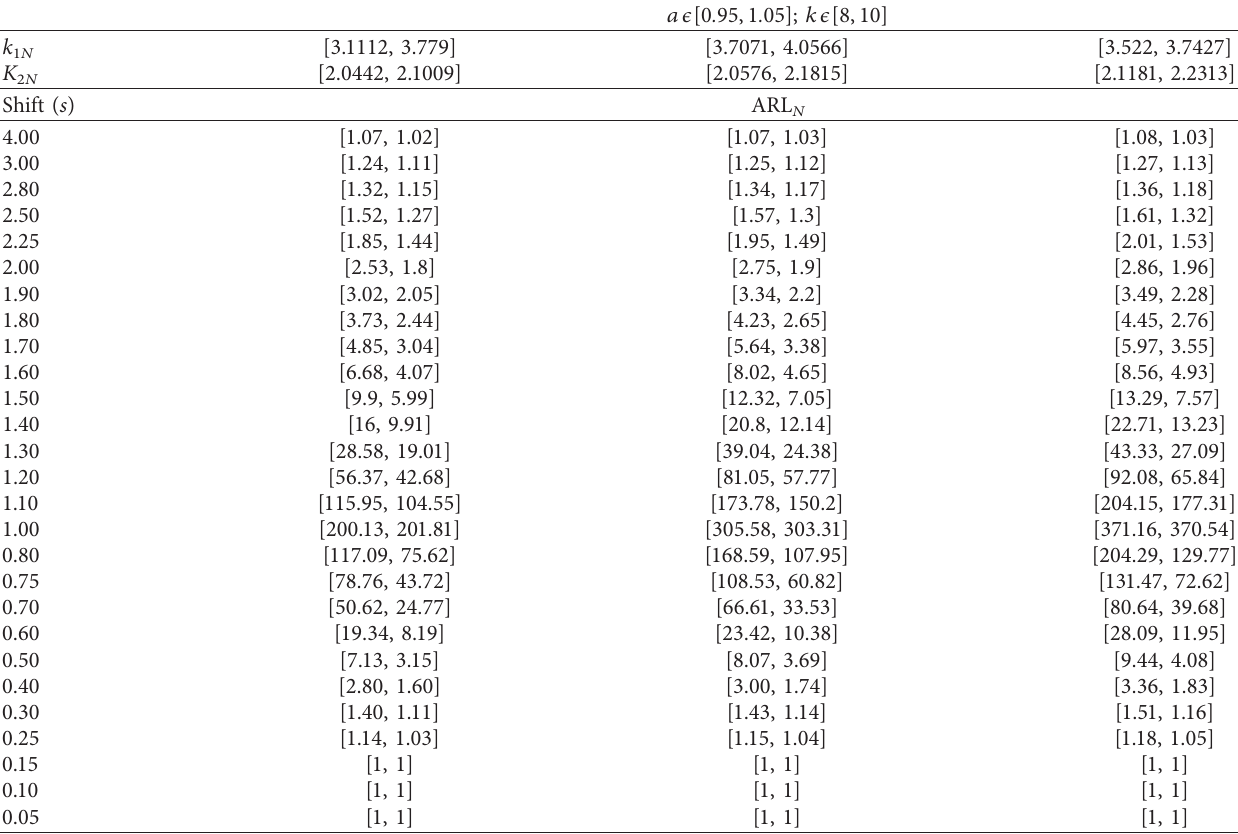
Table 4: The values of NARL when a � 0 . 95 and 1 . 05 and k � 8 and